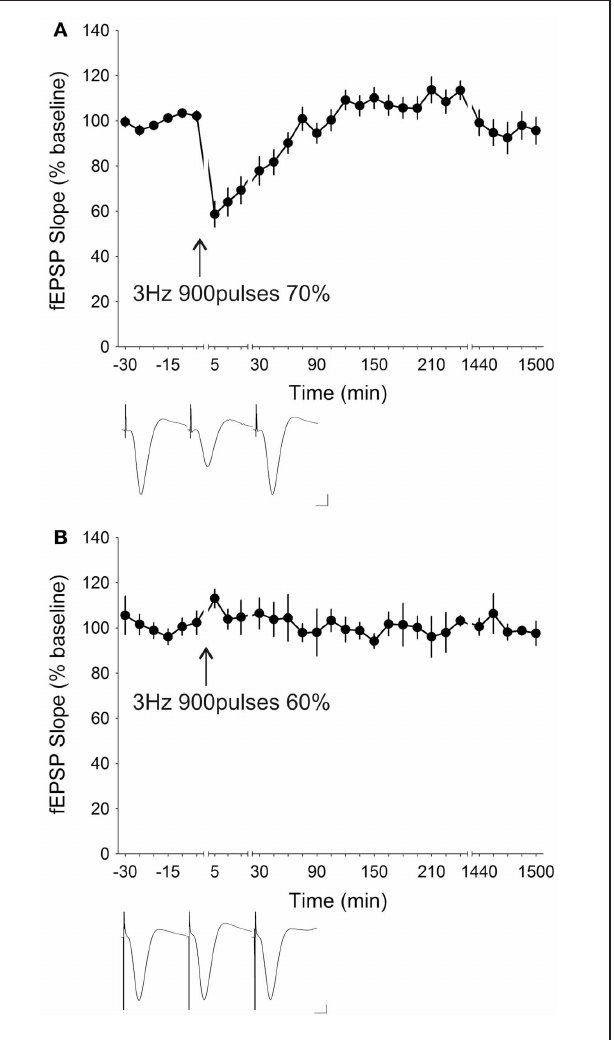
FIGURE 5 | The extent of short-term depression induced by low-frequency stimulation at 3Hz depends on the number of stimuli and the stimulation intensity. (A) Further increasing the number of stimuli to 900 times at 3Hz resulted in an STD that was depressed (ANOVA, p = 0 . 16118; n = 14) for 60min post-stimulation. At 900 stimuli initial synaptic depression was, however, considerably ameliorated (58 . 64 ± 5 . 74%) compared to at 200 and 300 stimuli and a late-onset potentiation developed after approximately 60min. (B) Decreasing the stimulation intensity used for 3Hz 900 stimuli LFS to 60% of the maximum inducible fEPSP which was aimed at circumventing the late-onset synaptic potentiation failed to induce any significant (ANOVA, p = 0 . 70365; n = 6) form of synaptic plasticity at the CA1 synapses. Insets: analog traces illustrating the Schaffer collateral–CA1 field potentials at pre-stimulation, 5min and 24h (1440min). Vertical scale bar corresponds to 2mV and horizontal scale bar corresponds to